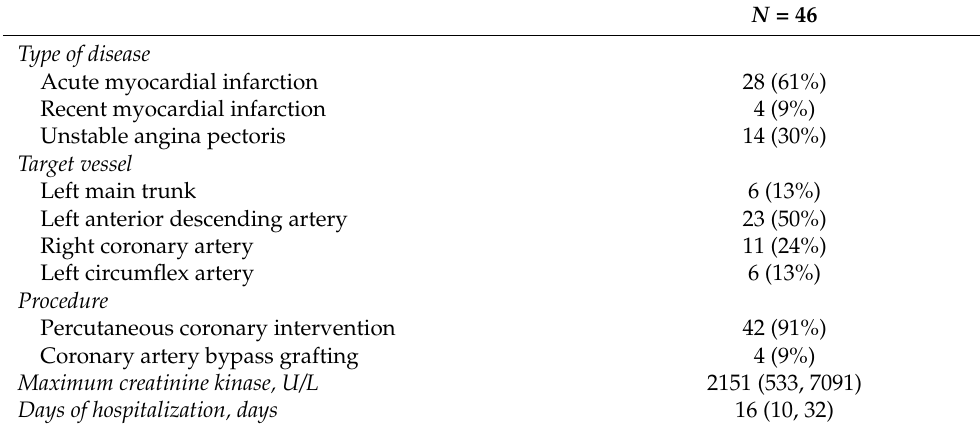
Table 2. Procedure characteristics.